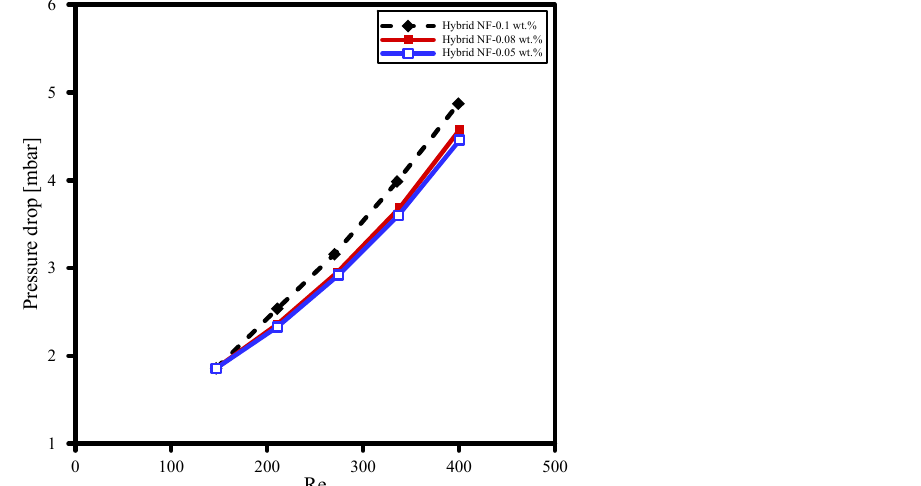
Figure 16. Pressure drop of FPSC with water-based (hBN/CF-CNTs) nanofluid for various Reynolds numbers at 960 W/m 2 and inlet temperature 30 °C.